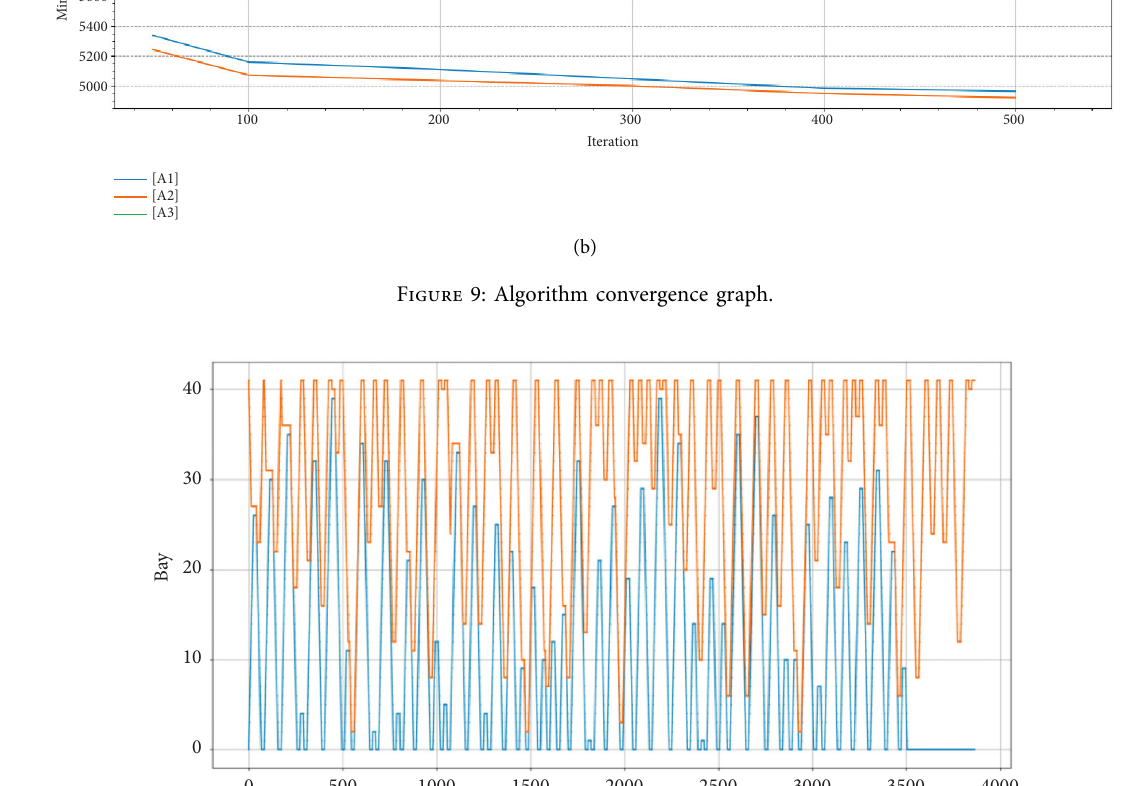
Figure 10: Tracks of the twin ASCs under seaside priority